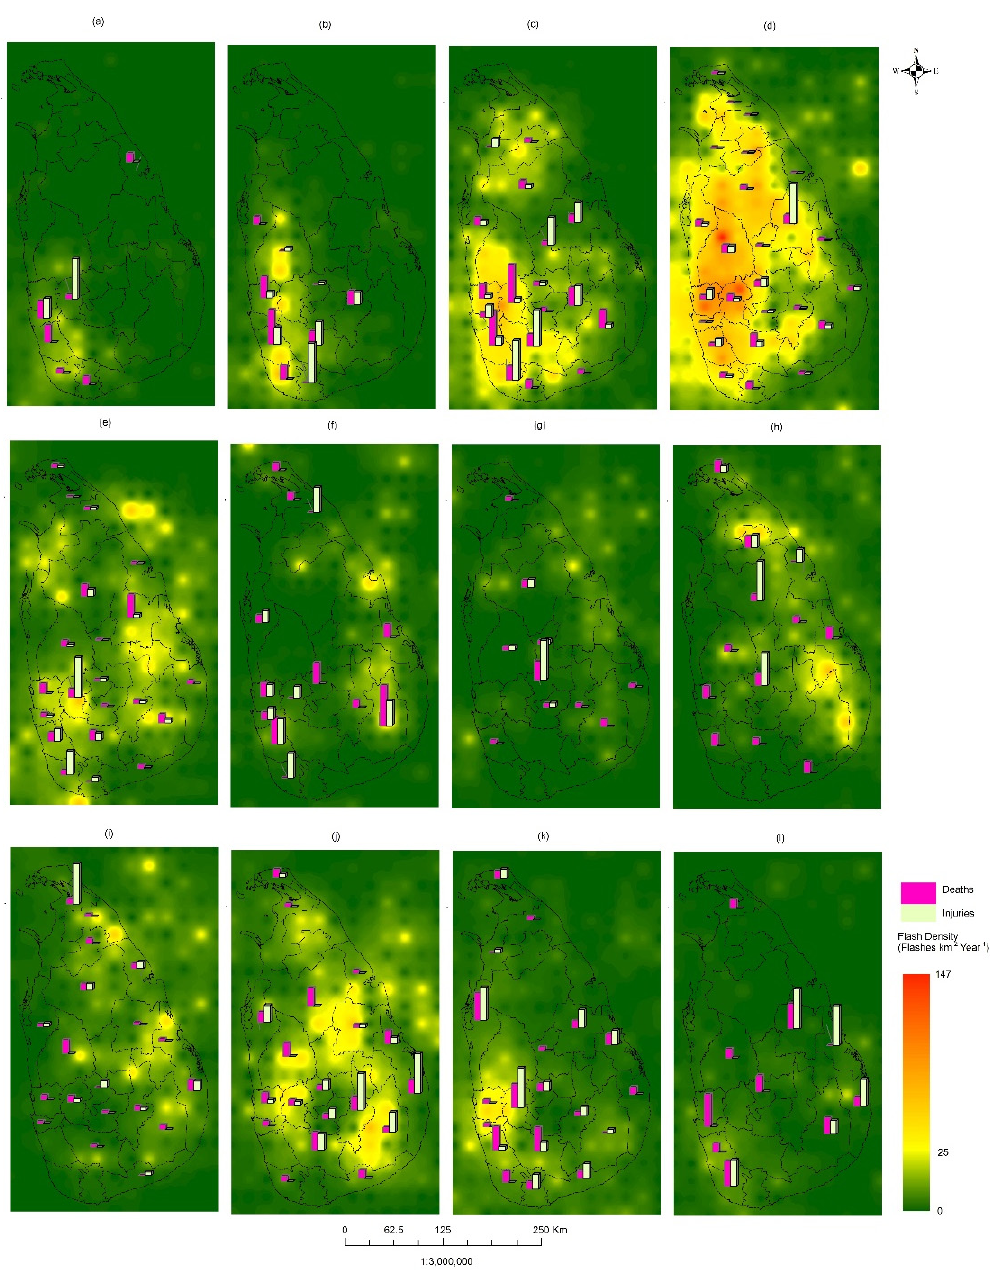
Figure 12. Variation of the lightning flash density with the recorded deaths and injuries (in %) in Sri Lanka from 1974 to 2019 for all 12 months, presented district-wise: ( a ) January, ( b ) February, ( c ) March, ( d ) April, ( e ) May, ( f ) June, ( g ) July, ( h ) August, ( i ) September, ( j ) October, ( k ) November, and ( l ) December.